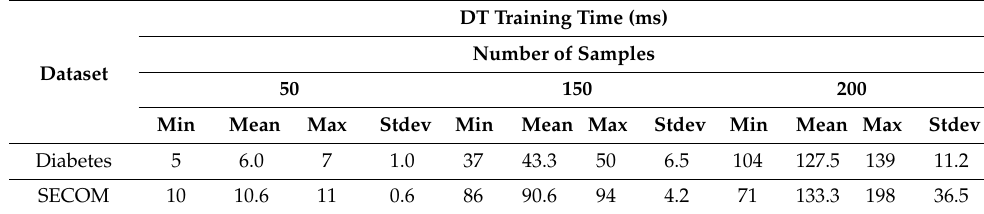
Table 7. Decision tree training time on the edge device.